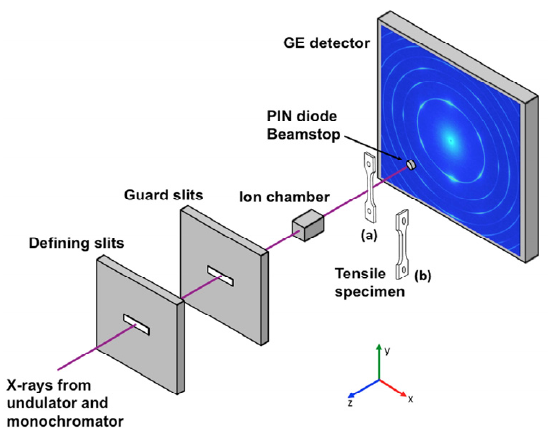
Figure 4. Schematic of the synchrotron experimental setup; the diffraction pattern in the schematic is from the bulk measurement of the un-irradiated MA957 tensile specimen. Sample position (a) is for bulk measurement of the un-irradiated MA957 tensile specimen; and sample position (b) is for X-ray diffraction scan of the ion-irradiated MA957 tensile specimen.